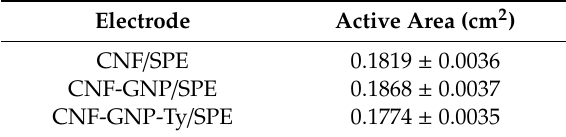
Table 3. The area of the active surface of the electrodes used in the analysis.